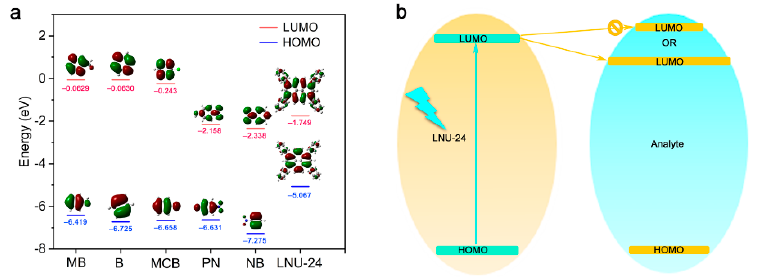
Figure 4. ( a ) HOMO and LUMO for tested analytes and LNU-23; ( b ) scheme of electron transfer phenomena between LNU-23 and the analyte via PET mechanism.